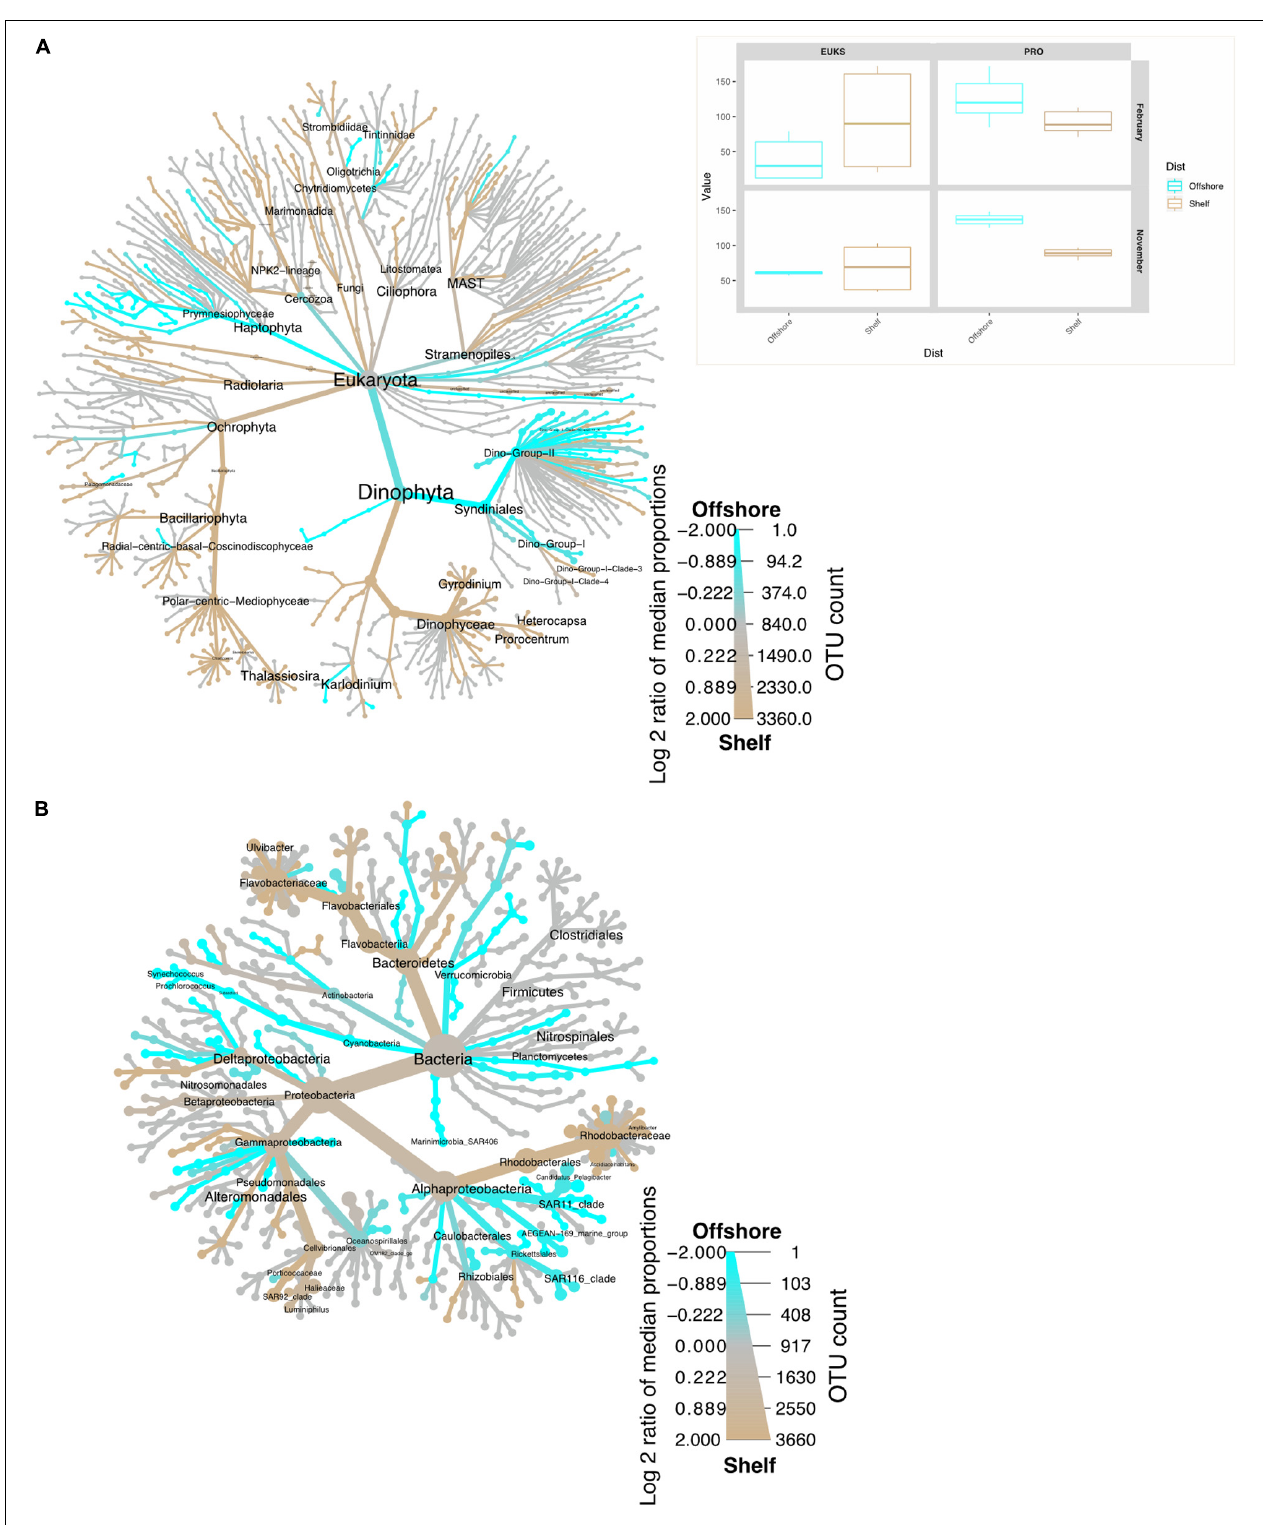
FIGURE 3 | Heat trees representing taxon distribution inshore (beige) vs. offshore (aqua blue) for November 2015 and February 2016 samples from the St Helena Bay Monitoring Line. The color of each taxon represents the log-2 ratio of median proportions of reads observed in shelf or offshore samples. (A) 16S (B) 18S. Inset represents the true diversity index (Shannon) for the same samples, plotted in the same color scheme. Only significant differences are colored, applying a Wilcox rank-sum test followed by Benjamini-Hochberg (HDR) correction for multiple samples.